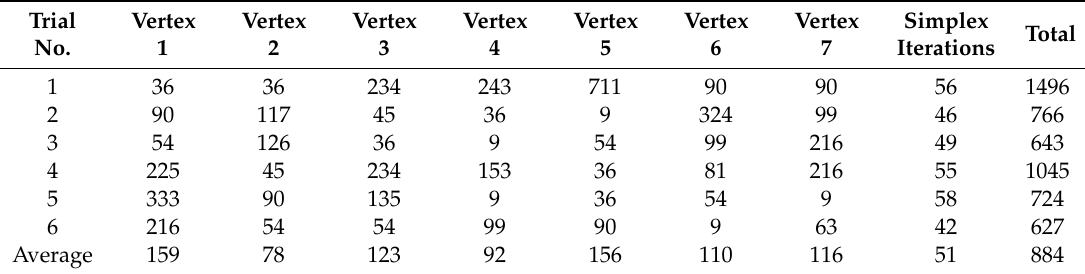
Figure 12. Reduction in error on applying simplex optimization on solutions obtained from GA. Table 6. Number of iterations required by GA to obtain maximum targeted error for further application of Simplex